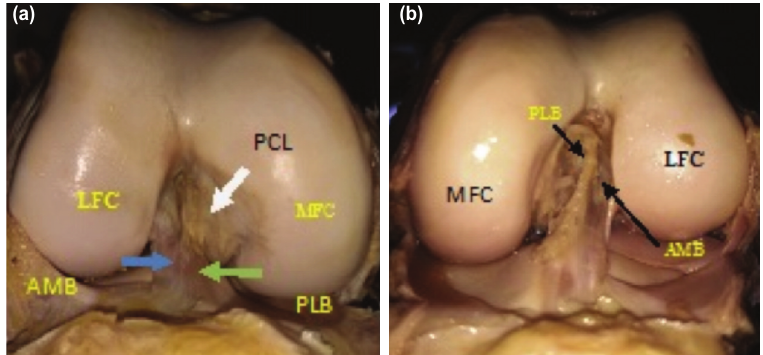
(a) AM and PL bundles in right knee (male). (b) AM and PL bundles of ACL in left knee (male). Fig. 1: